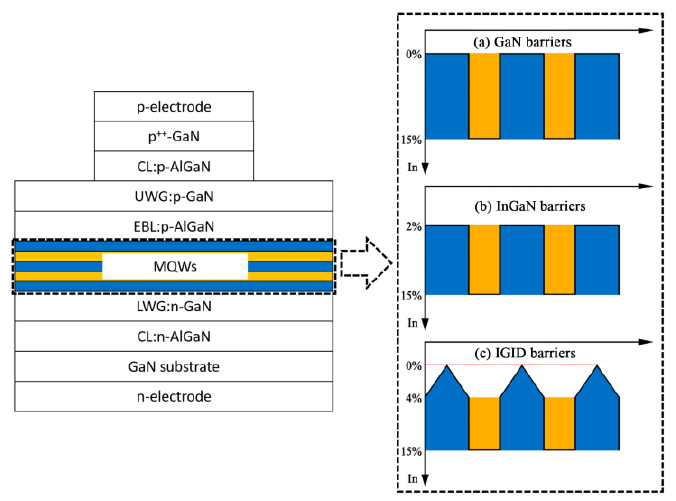
Figure 1. Schematics of LD structures with ( a ) GaN, ( b ) InGaN, and ( c ) IGID barriers.